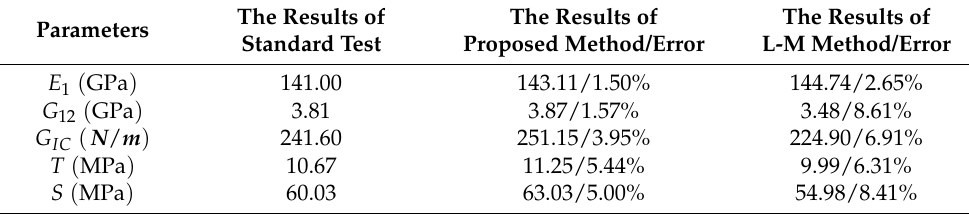
Figure 12. The SA results of each property to load under different strains at MP9 in stage 2. Table 4. The identification results of mechanical properties under different